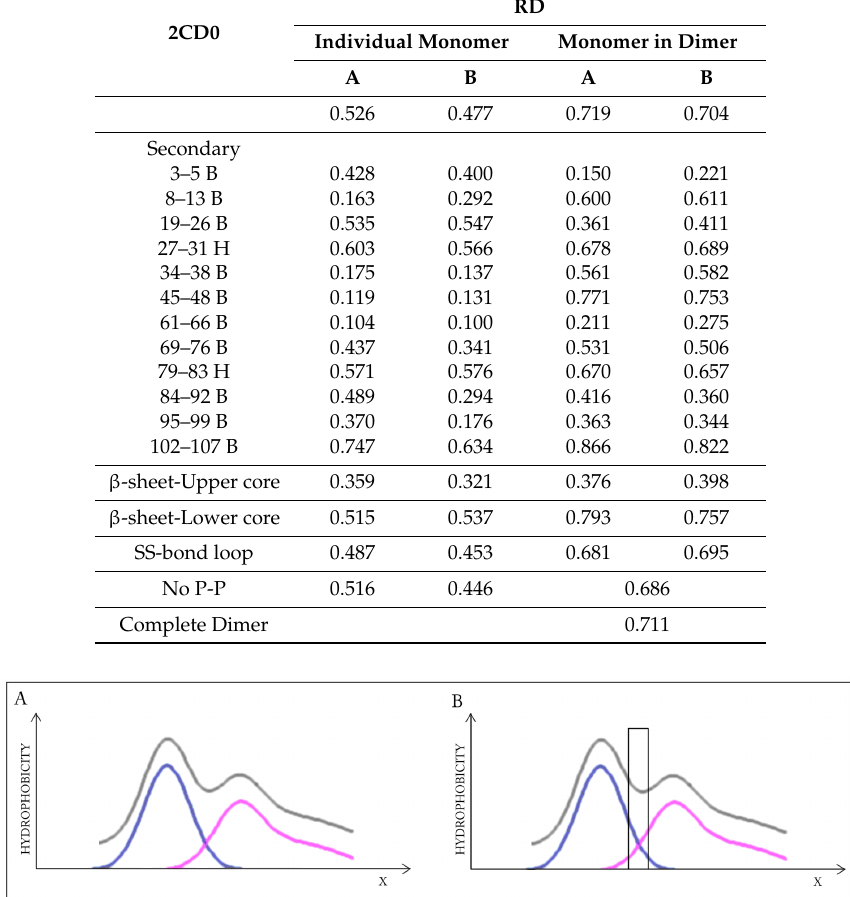
Figure 5. Schematic depiction of a system in which only one monomer contains a prominent hydrophobic core. Elimination of residues involved in complexation (right-hand image) leads to better accordance with the model when considering the dimer as a whole. Blue and pink lines: distributions in monomers, gray line: distribution in dimer. ( A ) Status of the individual monomers ( blue and pink ) versus the resultant distribution in dimer ( gray ); ( B ) The removal of the interface ( black bar ) does not change the status of the dimer—Distribution still discordant versus the expected one.